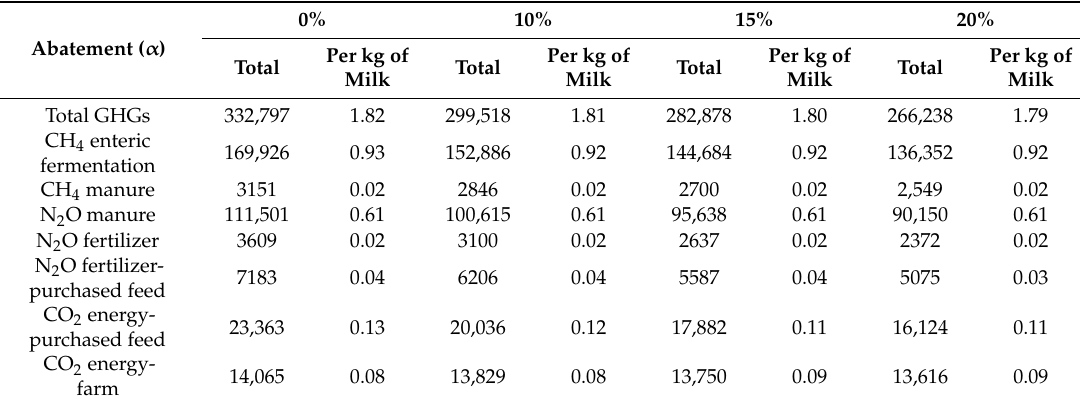
Table 8. Annual GHG emissions of the intensive farm (in kg of CO 2